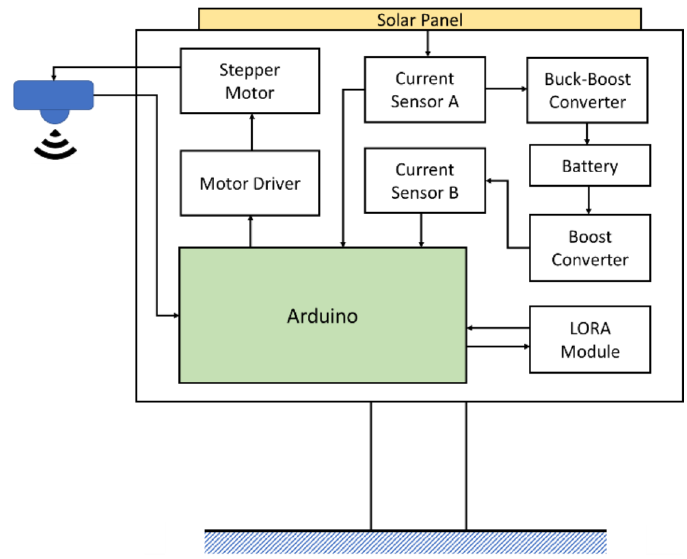
Figure 8. Block diagram of the proposed water level monitoring system.